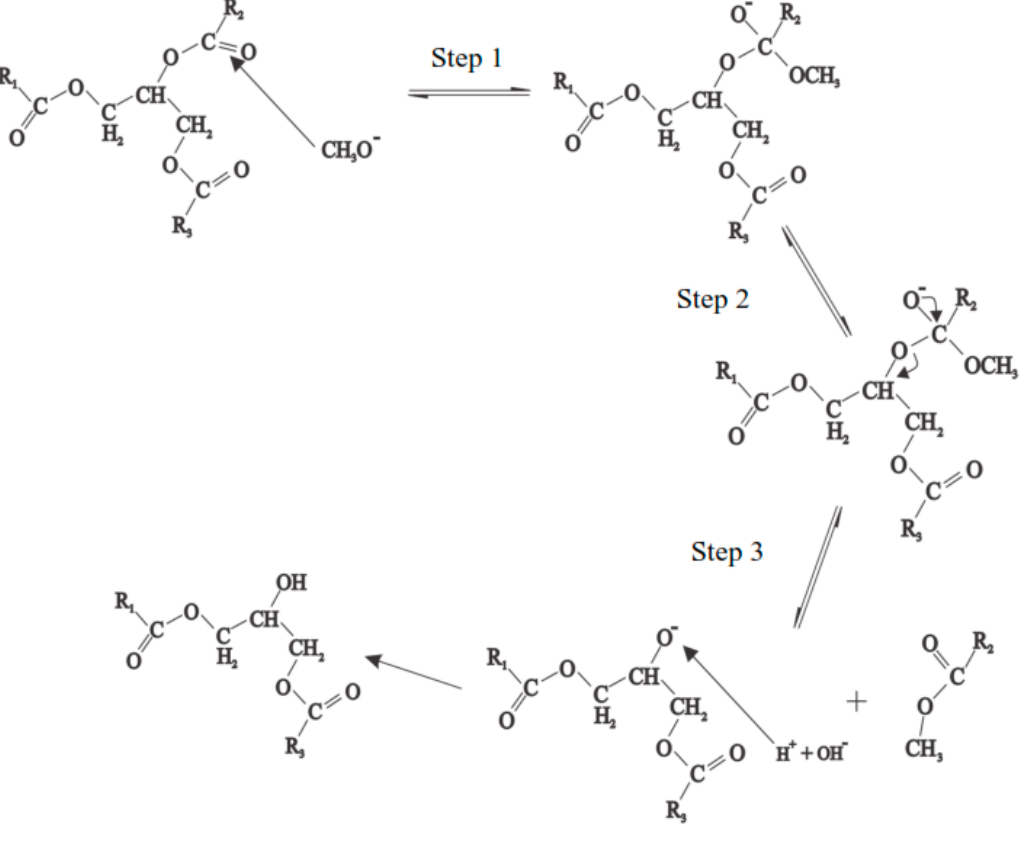
Figure 4. Triglyceride reaction with alcohol (this study).